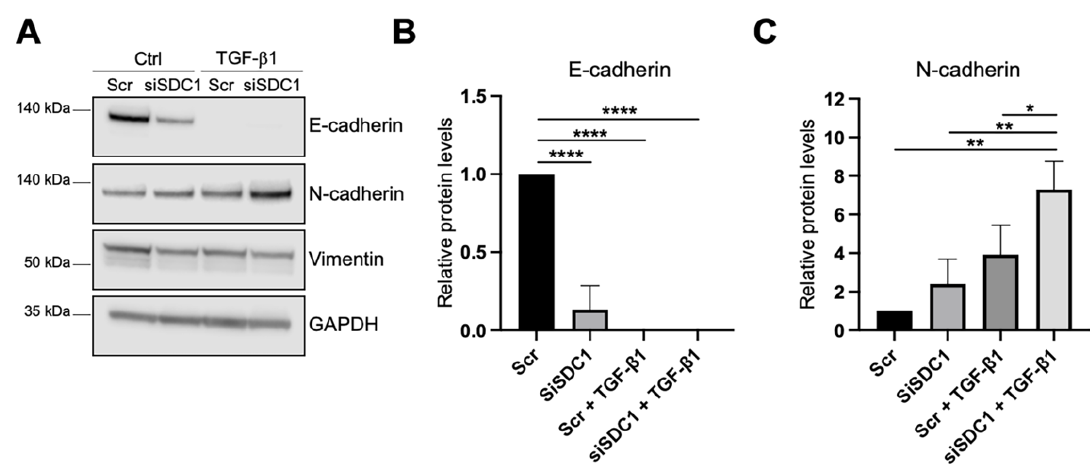
Figure 3. Effect of SDC1 knockdown on TGF- β 1-induced EMT in A549 cells. ( A ) Western blot results showing the effect of SDC1 knockdown and TGF- β 1 treatment (10 ng/mL, 48 h) on E-cadherin, vimentin, and N-cadherin protein levels in A549 cells. GAPDH was used as a loading control. ( B , C ) Bar graphs showing quantification of western blot results from studying the effect of SDC1 knockdown and TGF- β 1 treatment (10 ng/mL, 72 h) on protein levels of E-cadherin ( B ) and N-cadherin ( C ). Values were normalized to GAPDH and related to the levels of each protein in untreated Scr control cells. The results represent mean values of three independent experiments. * = p < 0.05; ** = p < 0.01; **** = p < 0.0001.